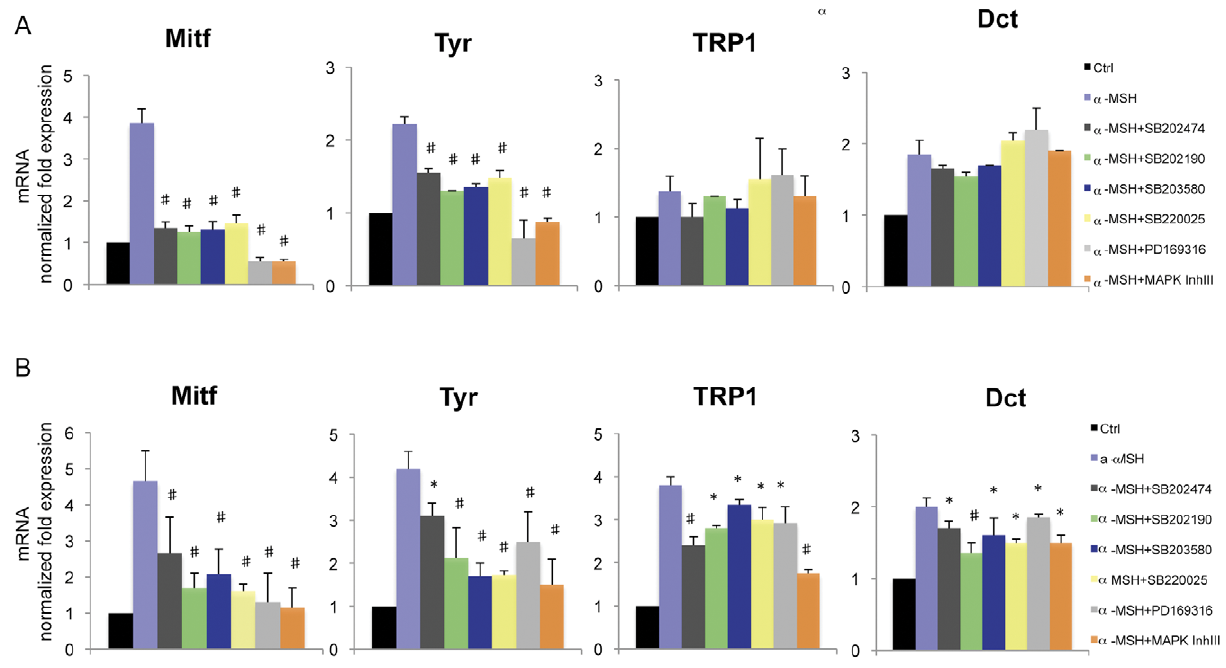
Figure 2. The effect of pyridinyl imidazoles on melanogenic gene expression. (A) Semi-qunatitative real-time PCR was used to measure Mitf, tyrosinase, TRP1 and TRP2 mRNAs expression in B16-F0 cells after 6 h and (B) 24 h of tratments. The graphs show fold differences in transcript abundance in untreated cells, and a -MSH-treated cells (0.1 m M) in presence or not of PI compounds (SB202474, SB202190, SB203580, SB220025, PD169316 20 m M: MAPK Inh III 10 m M). The results shown in (A) and (B) were normalized by the b -actin mRNA levels. The data show the mean 6 SD of four experiments performed in triplicate. *P # 0.05; # P # 0.01 versus control.